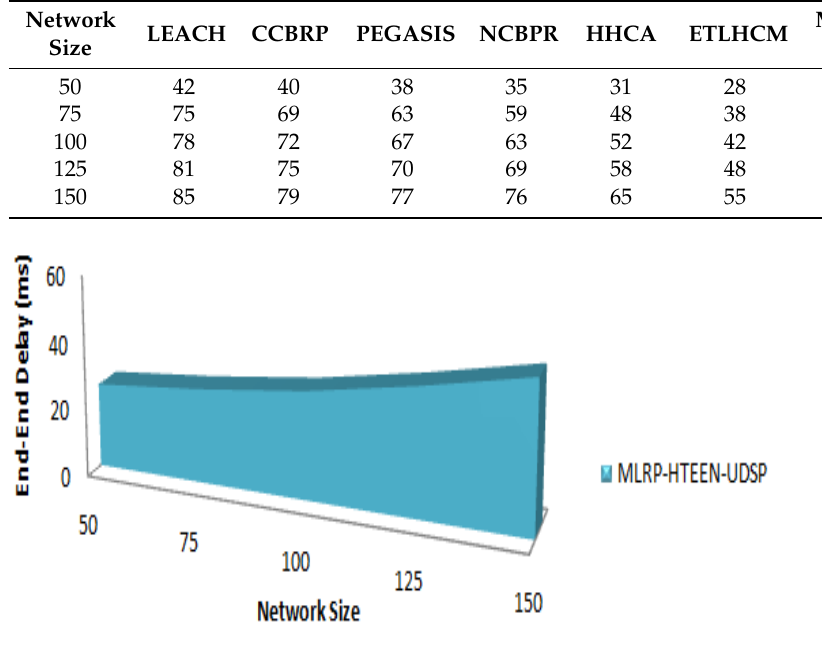
Figure 3. End-to-end delay of MLRP-HTEEN-UDSP.